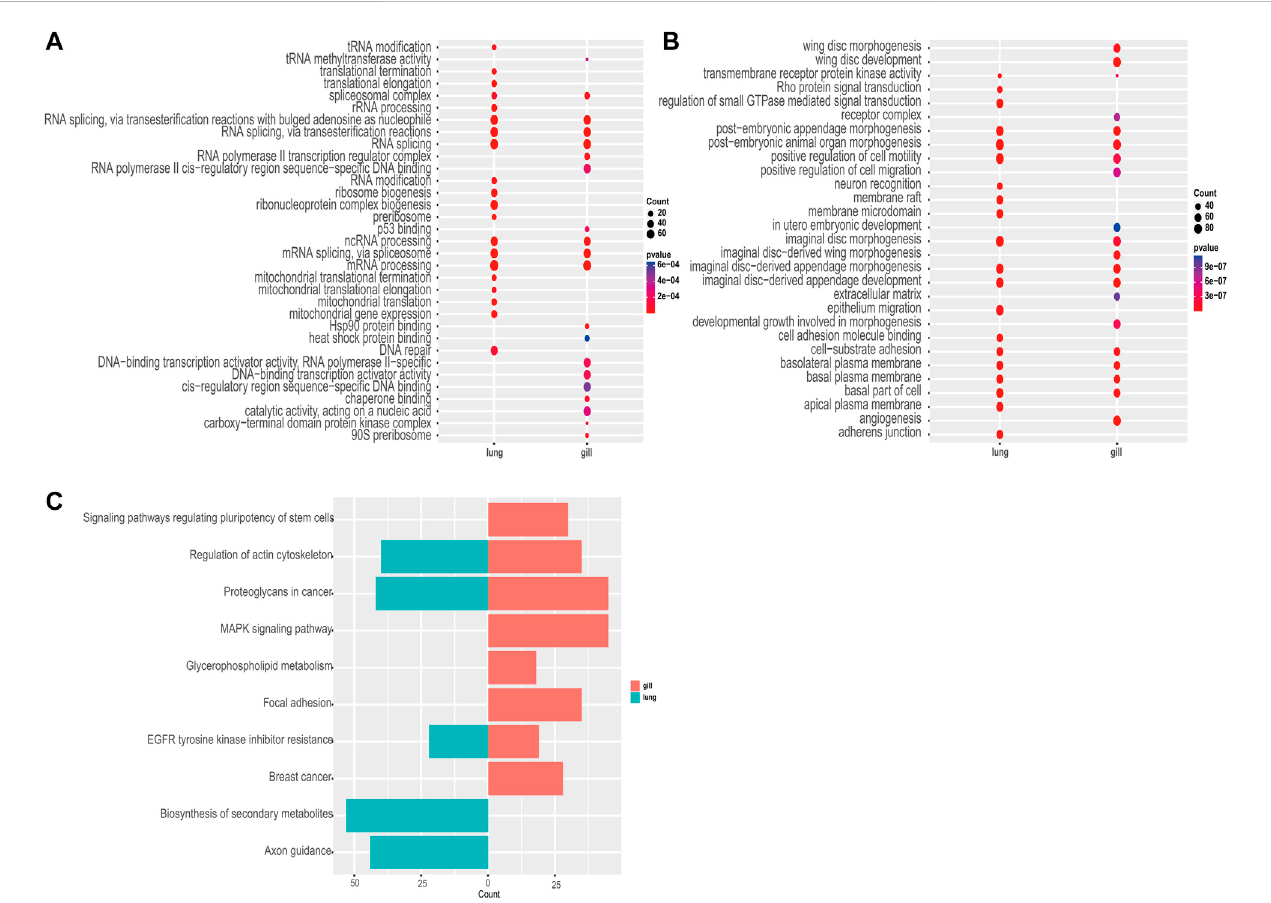
FIGURE 3 Enrichment analysis. (A) GO enrichment analysis of commonly upregulated genes in aestivating lung fi sh. (B) GO enrichment analysis of commonly downregulated genes in aestivating lung fi sh. (C) KEGG enrichment analysis of commonly downregulated genes in aestivating lung fi sh.